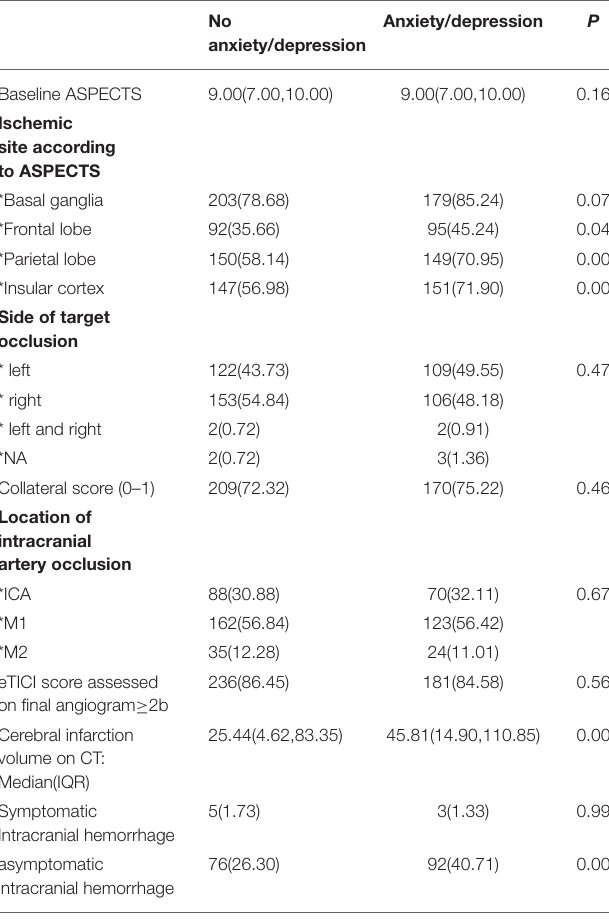
TABLE 2 | Imaging characteristics of patients in anxiety/depression group and no anxiety/depression group. No Anxiety/depression anxiety/depression